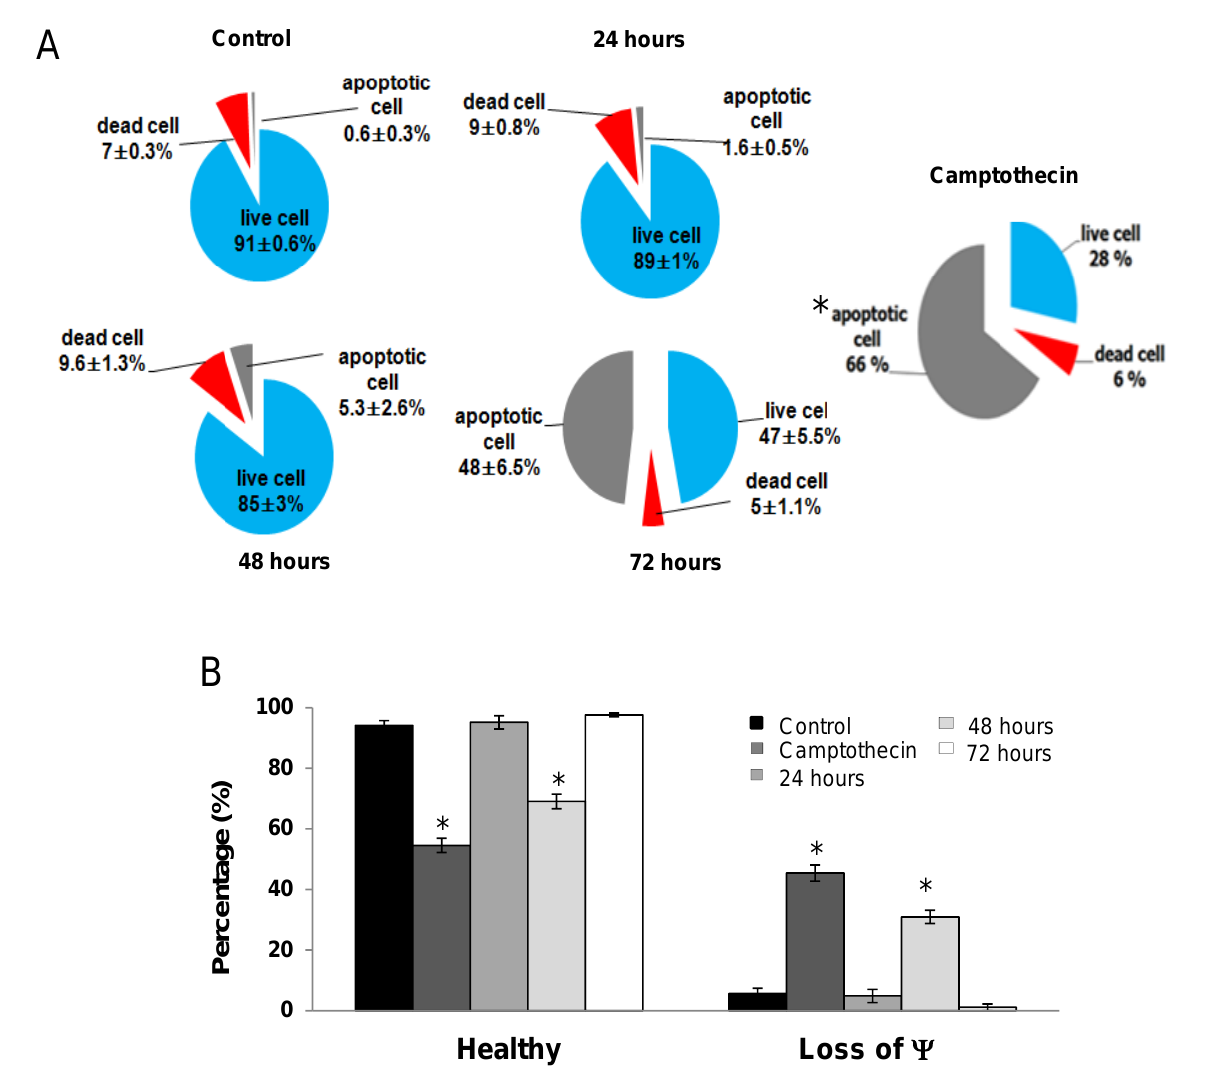
Figure 3. RTEAL induces apoptosis and mitochondrial dysfunction. Cells were treated with RTEAL at 28 µg/mL for up to 72 h. ( A ) Distribution of apoptotic and dead cells. ( B ) Loss of mitochondrial membrane potential ( Ψ ). Data were presented as mean ± SEM of the three independent experiments. Asterisks indicate a significant difference (* p < 0.05) for each treatment was compared to the control cells.